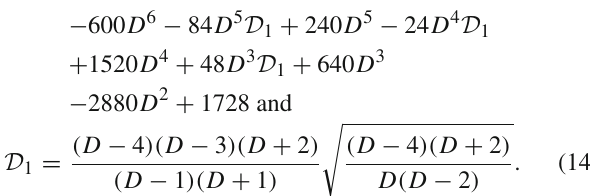
Table 2 Summary of nontrivial D = 3 α < 0 (cid:2) -term regimes